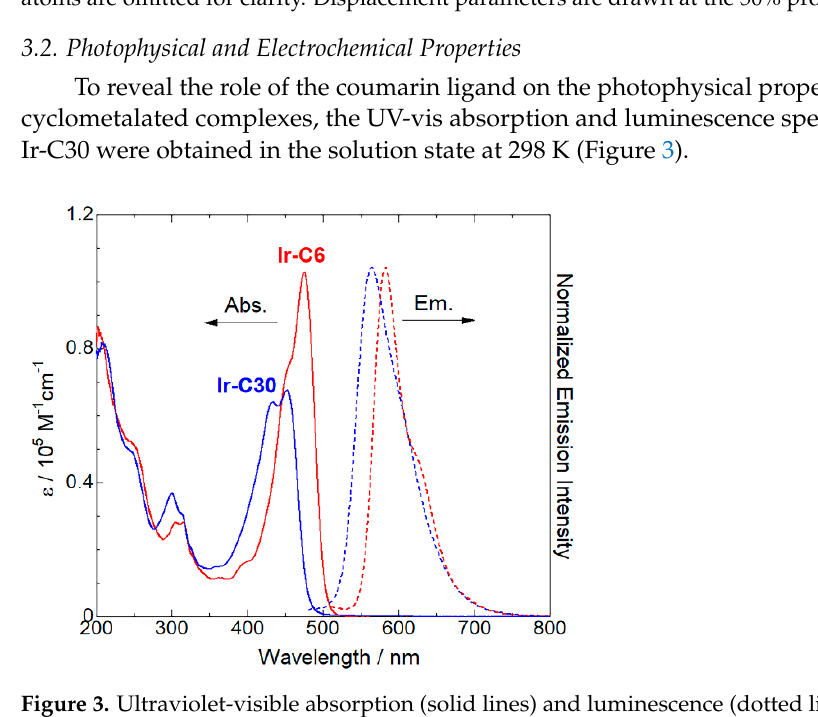
Figure 2. Molecular structure of Ir-C30. Ir(III) coordination sphere is depicted as a green octahedron. Brown, light blue, red, and pale pink ellipsoids represent C, N, O, and P atoms, respectively, and H atoms are omitted for clarity. Displacement parameters are drawn at the 50% probability level.